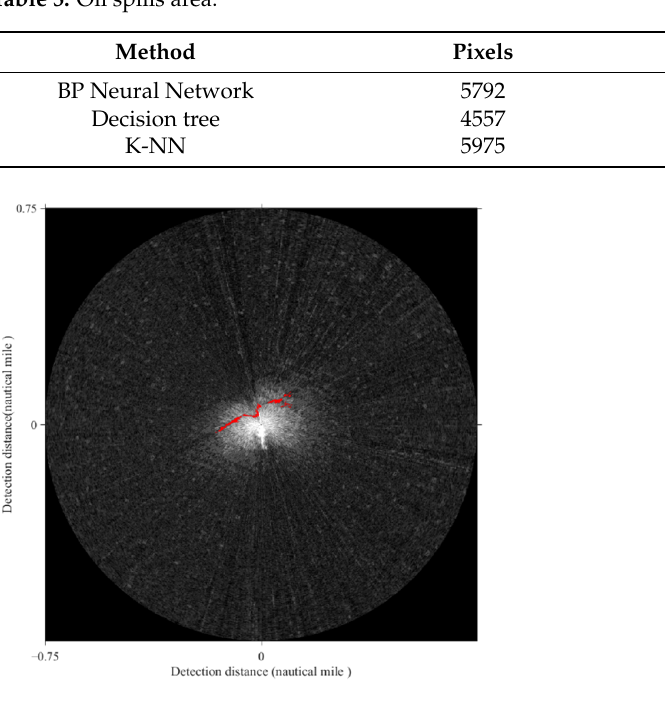
Figure 12. The oil spill result in the polar coordinate